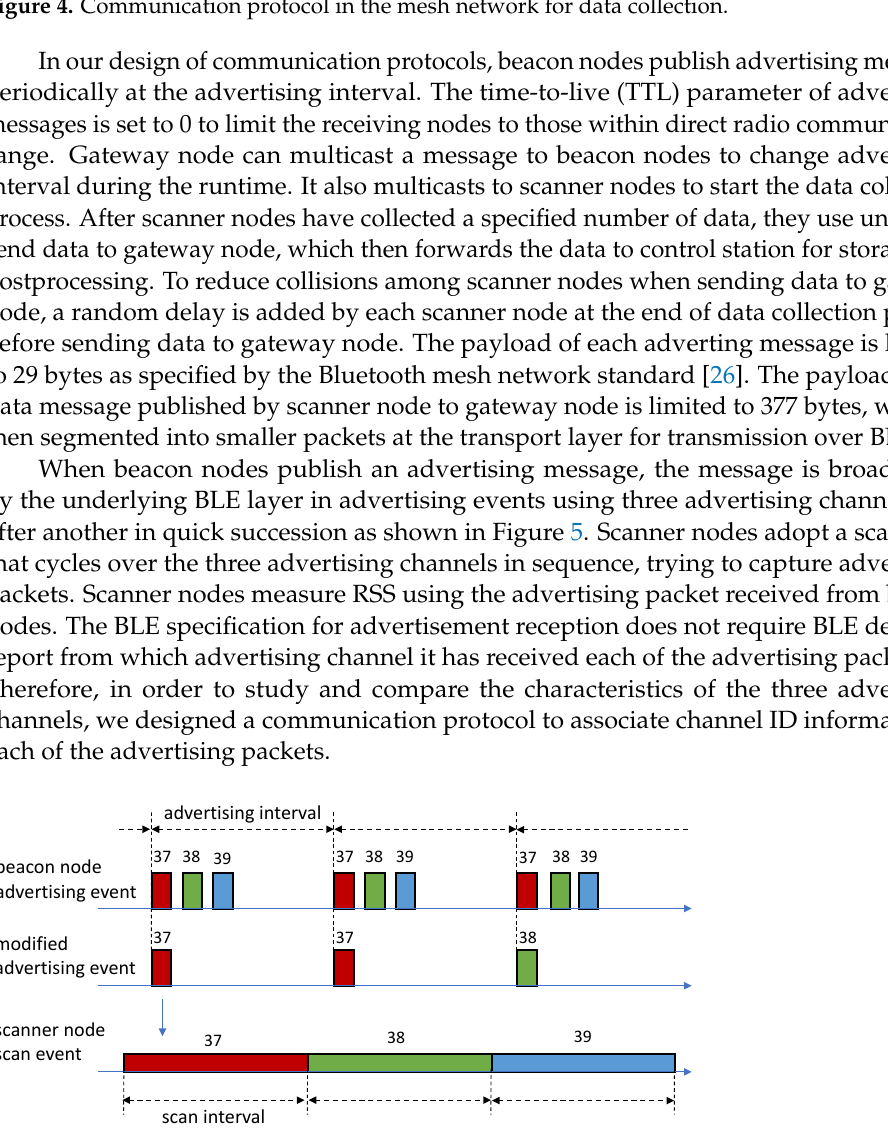
Figure 5. Modified adverting event for channel-aware advertising and scanning of the beacon advertising